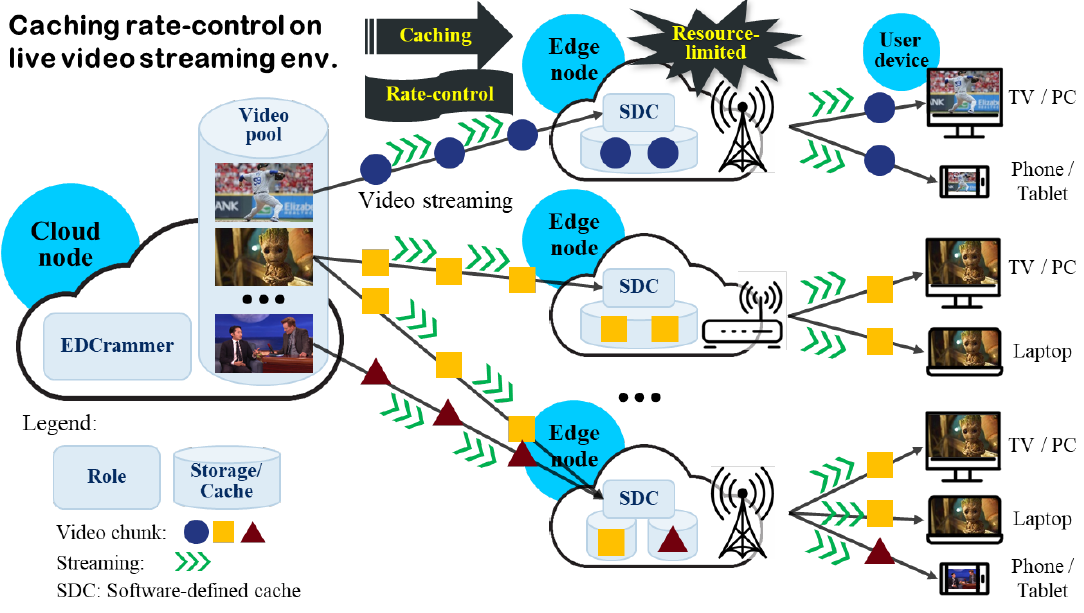
Figure 2. A concept of efficient edge caching between a cloud and edge nodes for live video